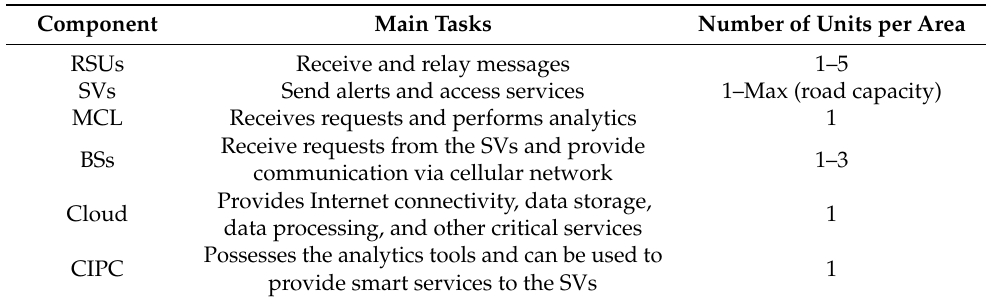
Table 2. The required infrastructure for the proposed moisture computing (MC) architecture.